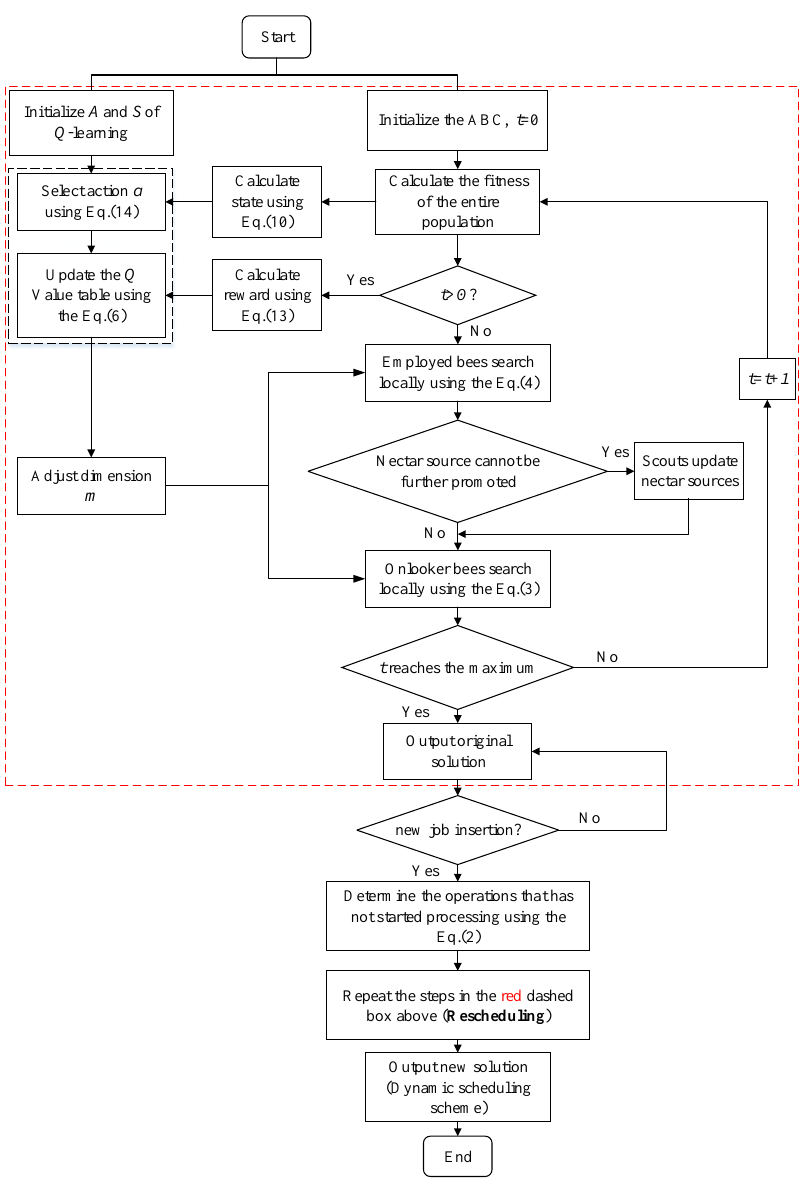
Figure 9. The flow chart of the DSLABC